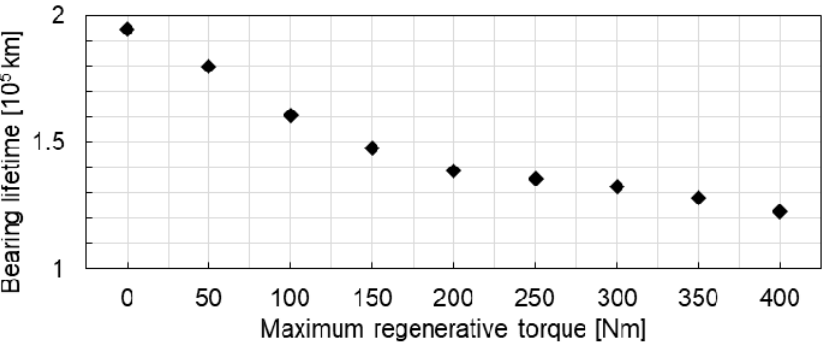
Figure 13. Results of the sensitivity analysis. Bearing lifetime over maximum regenerative torque in the WLTC.